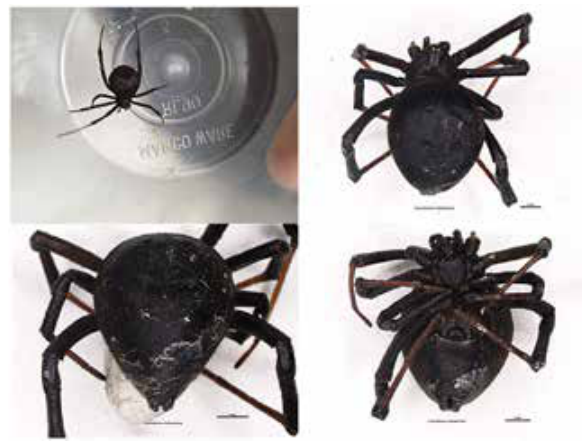
Figure 2: Dorsal and ventral images of spider: female Latrodectus indistinctus .